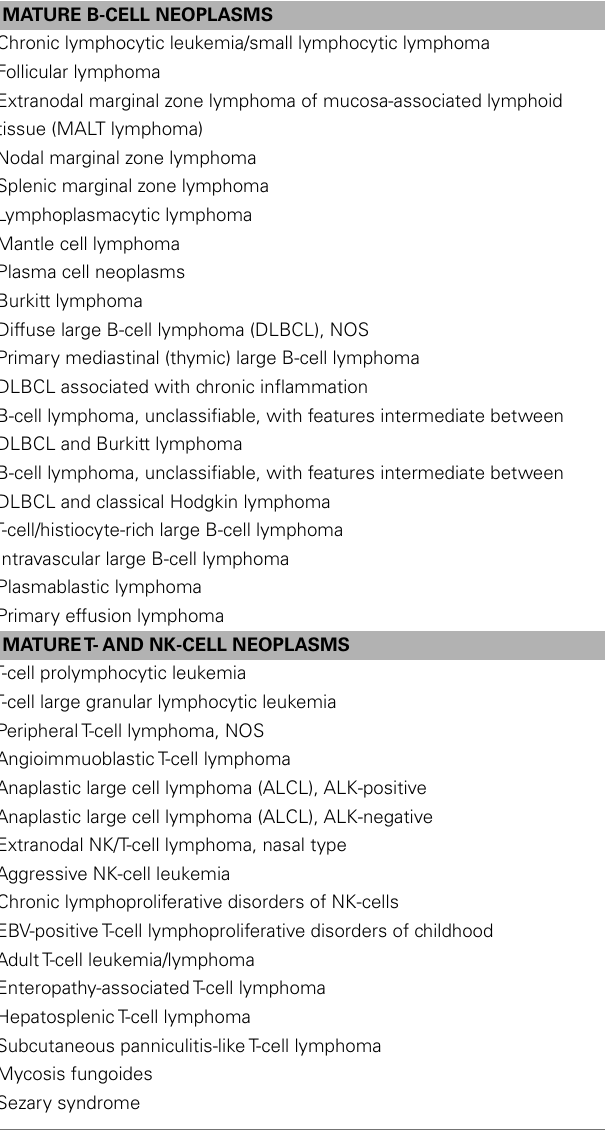
Table 1 | Major types of mature B-,T-, and NK-cell lymphomas. MATURE B-CELL